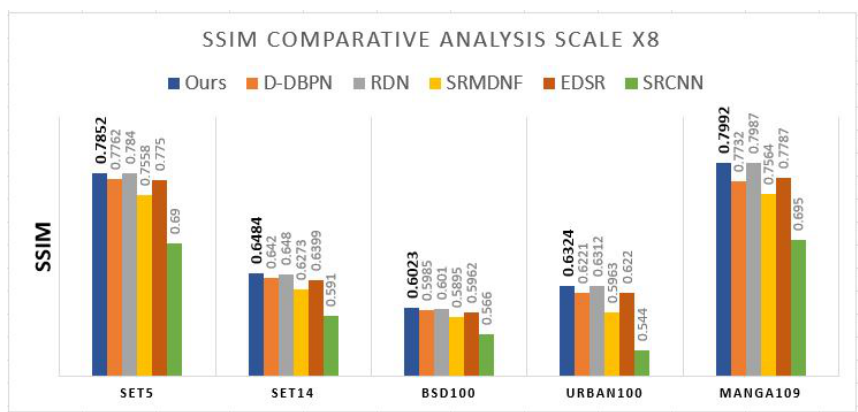
Figure 19. SSIMcomparison at × 8